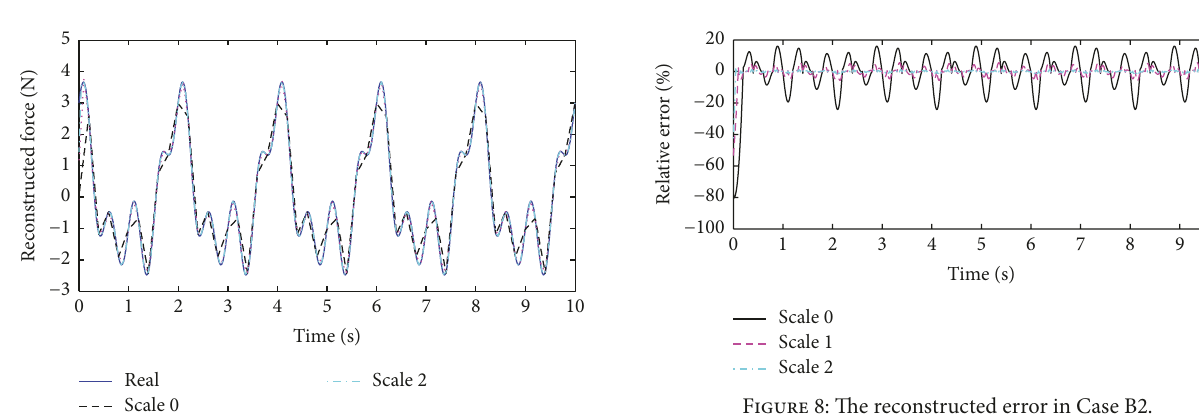
Figure 8: The reconstructed error in Case